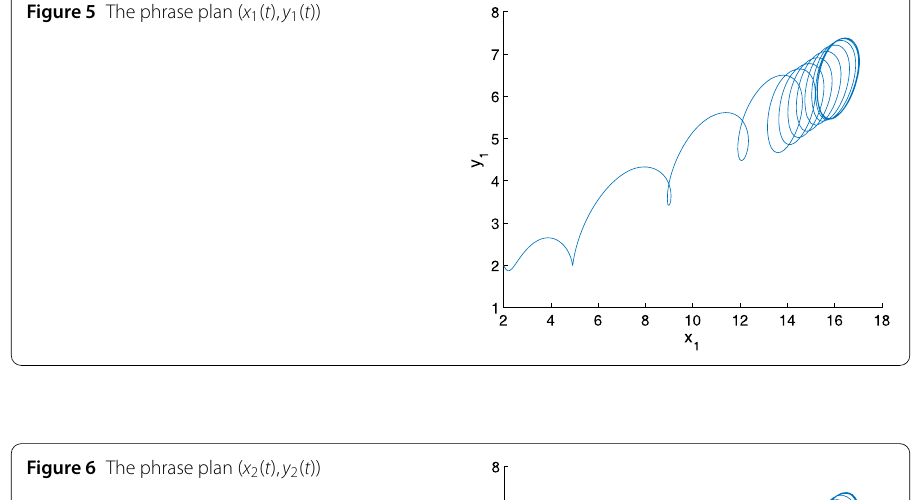
Figure 6 The phrase plan ( x 2 ( t ), y 2 ( t